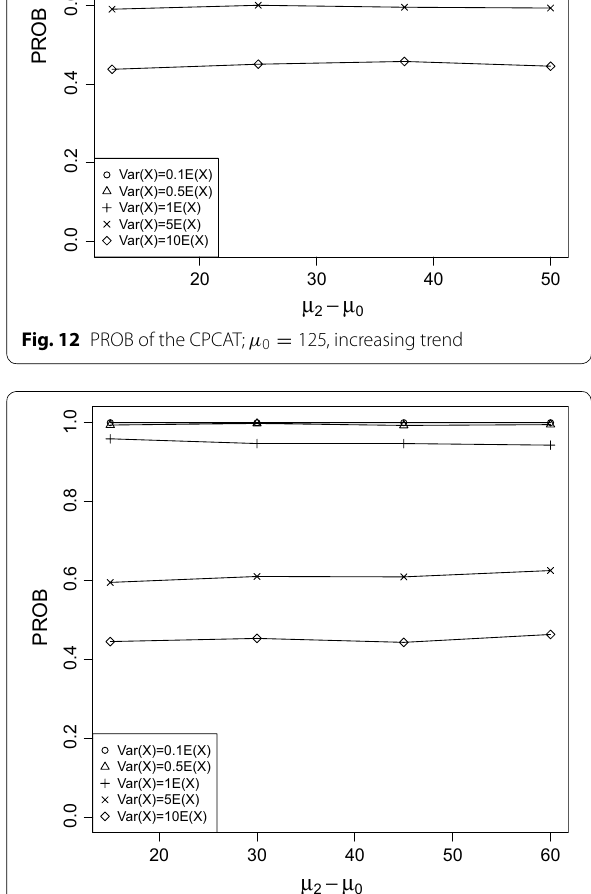
Fig. 13 PROB of the CPCAT; µ 0 = 150 , increasing